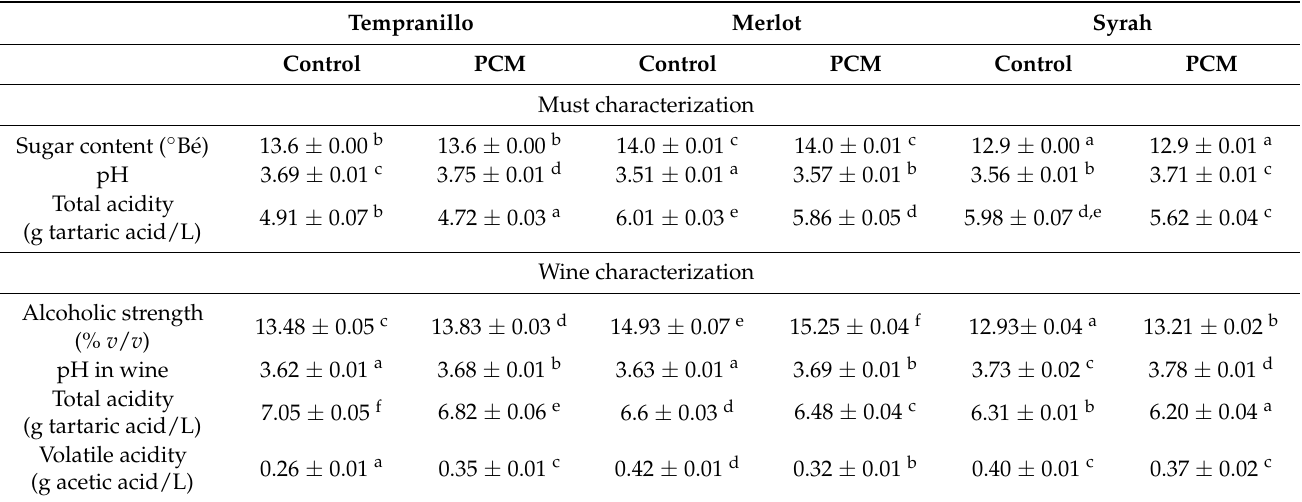
Table 1. General parameters of musts and wines.